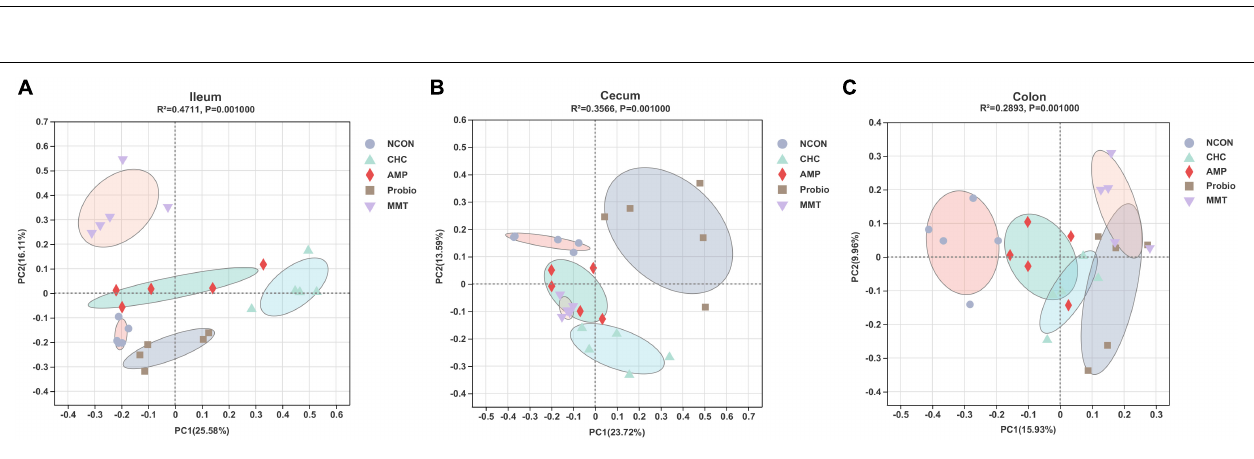
Frontiers in Microbiology |